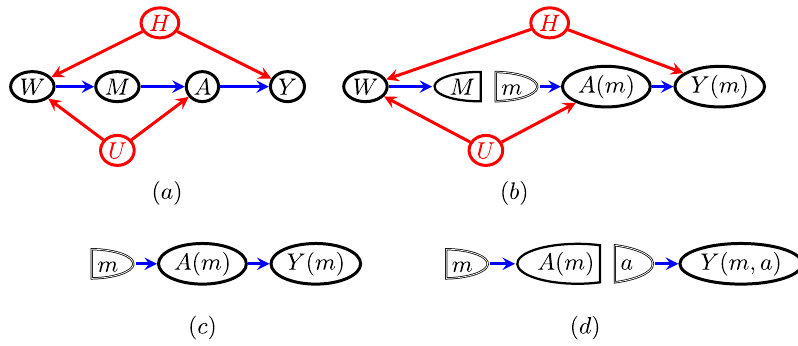
Figure 2: ( a ) A graphical counterfactual representation of the new napkin model. Interventions on all variables are allowed. ( b ) The SWIG representing the counterfactual distribution p Y m A m M W , , , ( ( ) ( ) ) in the new napkin model, where M is intervened to a value m . ( b ) The graph representing the counterfactual marginal distribution p Y m A m , ( ( ) ( ))